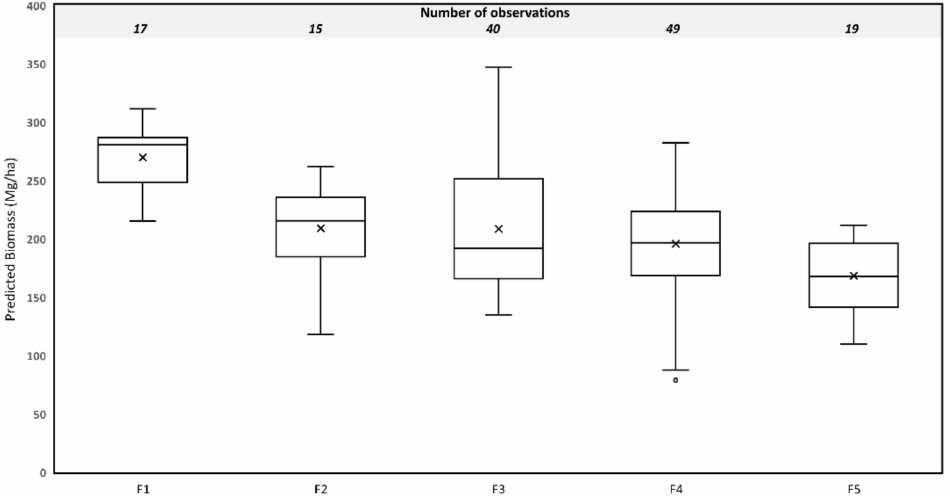
Figure 9. Boxplots of predicted values of AGB calculated for the five-class typology of degraded forest with the range (1st and 3rd quartile), the mean (line) and the median